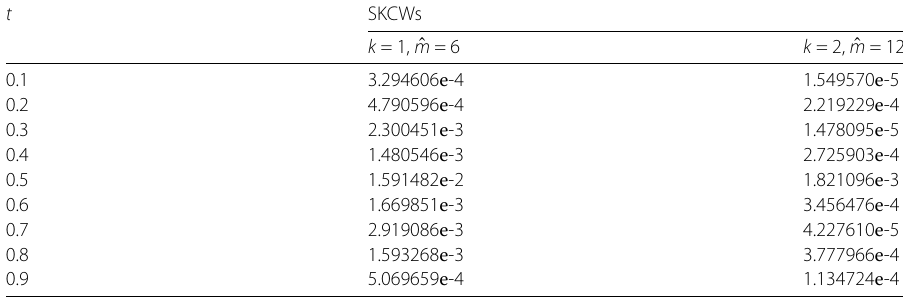
Table 1 Absolute errors at the interval [0,1) with M = 3, for Example 6.1 t SKCWs